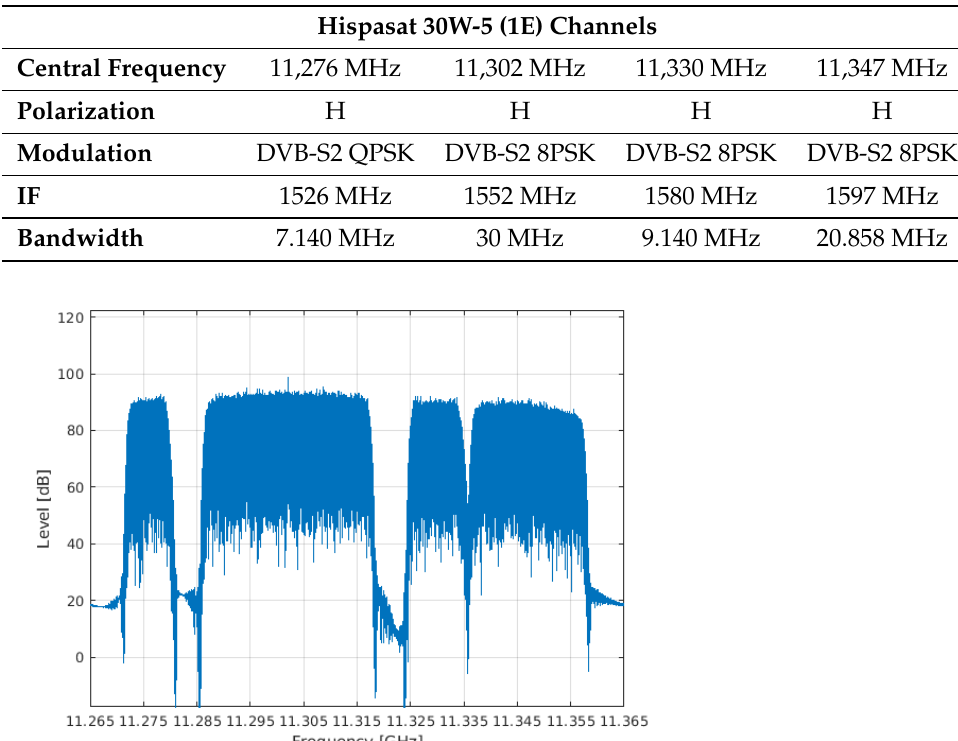
Table 1. Adquires DVB-S channels.